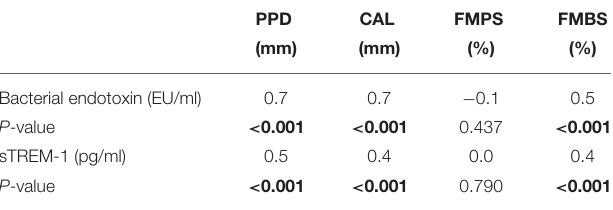
TABLE 2 | Correlation values ( r ) among biomarkers of bacterial burden and clinical periodontal parameters in the case-control study (one time point).